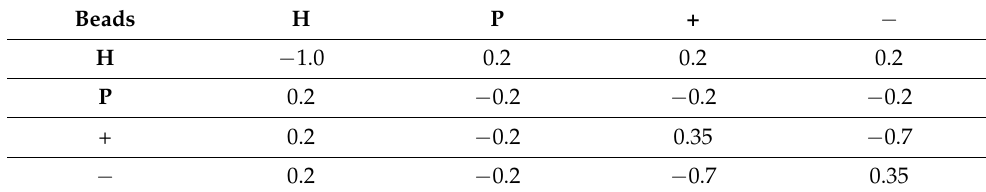
Figure 1. (Left) Single peptide of 8 beads that are +HHPPHH- in N* conformation. Red, green, yellow and blue refer to amino acids − , H, P, + , respectively. Native structure of 1 peptide chain is showed next to N*. Fibril structure of the systems of N = 6 and N = 12 chains in the lattice model. Table 1. Interaction energies between two beads of polypeptide chains e ij in the lattice model. The energy is measured in ε H , where ε H is the hydrogen bond energy.